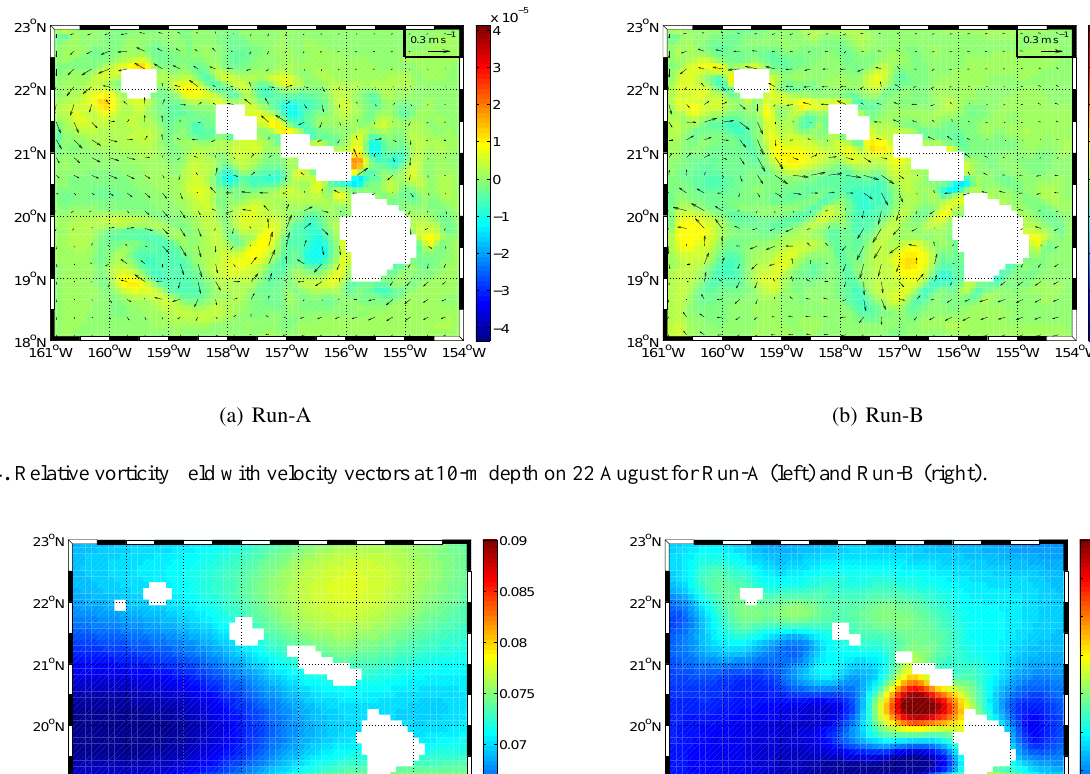
Fig. 5. Annually-averaged wind stress values [Nm − 2 ]. Different scales are used for a better visualization.